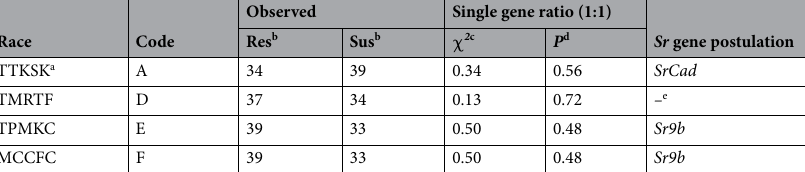
Table 2. Phenotypic ratios, chi squared analysis and Sr gene postulation for response to four Puccinia graminis races tested on the RL6071/Peace DH population. a Data from Hiebert et al. 2011 24 . b Res resistant, Sus susceptible. c Chi-squared value. d p-value for the chi-squared value. e No gene postulated for race